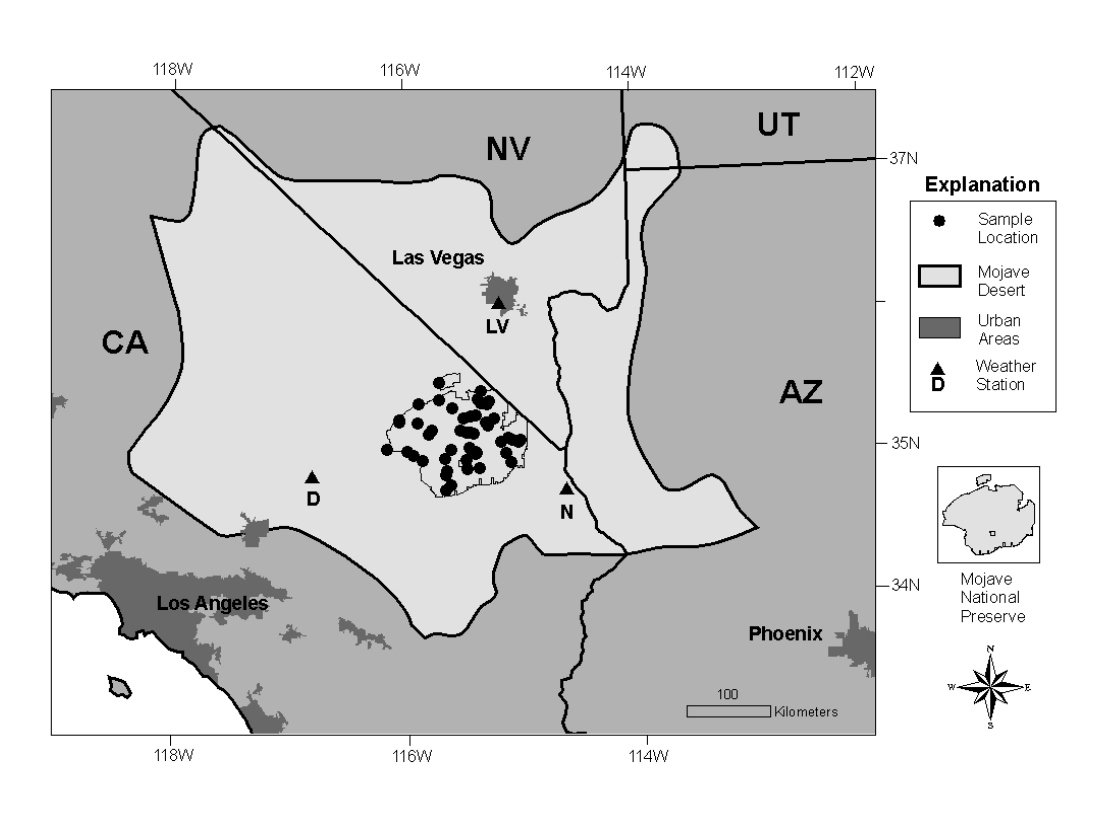
Figure 1. Map of the Mojave Desert ecosystem study area and the field sample locations. Weather stations shown are Las Vegas (LV), Daggett (D) and Needles